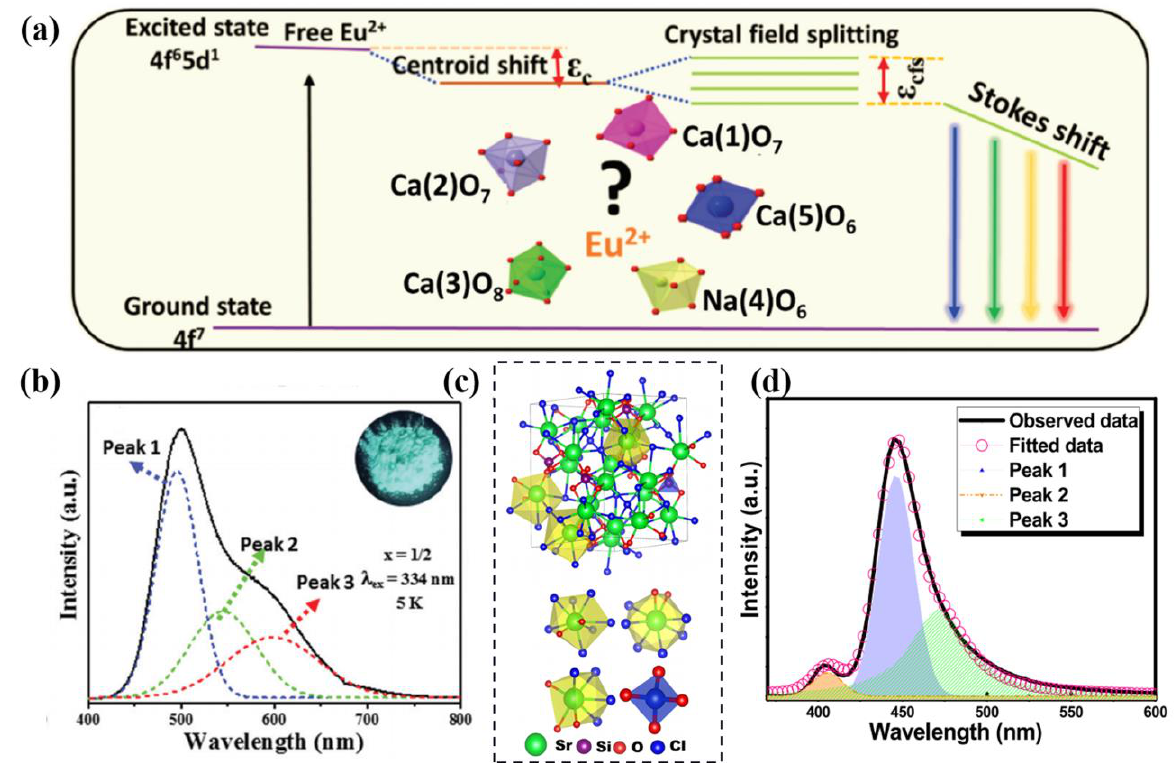
Figure 4. ( a ) Schematic diagram illustrating the influence of the crystal environment on the 5d energy levels of Eu 2+ doped in β -Ca 3 (PO 4 ) 2 -type compounds. ( b ) Gaussian fitting results of PL spectra for Ca 9 Na 3/2 Y 1/2 (PO 4 ) 7 :Eu 2+ . Reprinted with permission from ref. [41]. Copyright 2021 Royal Society of Chemistry. ( c ) Illustration of the crystal structure and Sr-polyhedral units of Sr 5 SiO 4 Cl 6 . ( d ) Room-temperature PL emission spectrum and three Gaussian curves of Sr 4.9 Eu 0.1 SiO 4 Cl 6 . Reprinted with permission from ref. [46]. Copyright 2019 American Chemical Society.